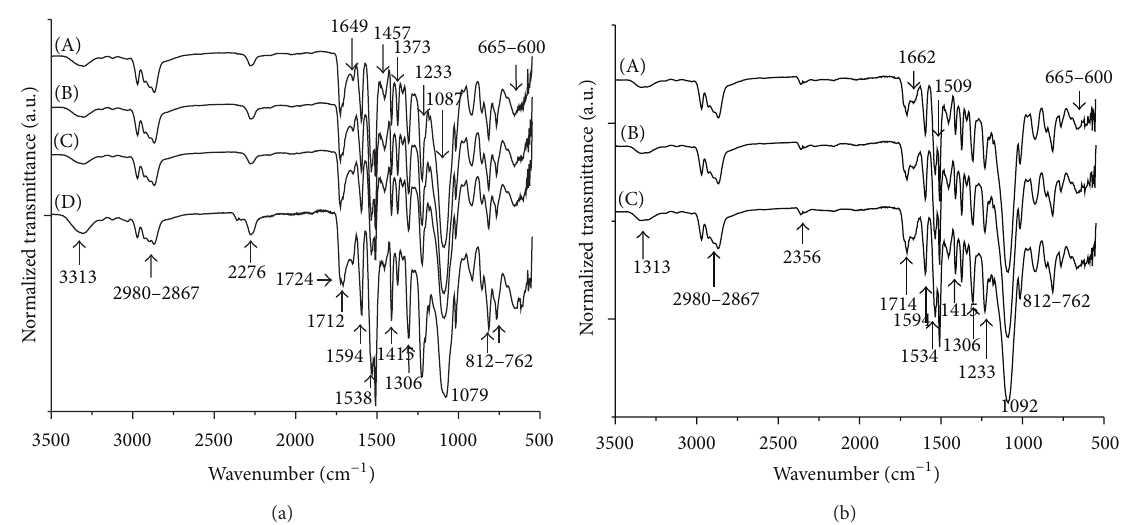
Figure 10: IR normalized spectra of PU-keratin membranes before removal process: (a) with MDI, (A) MPKAl, (B) MPKAc, (C) MPKN, and (D) MPH. (b) with TDI, (A) TPKAc, (B) TPKN, and (C)